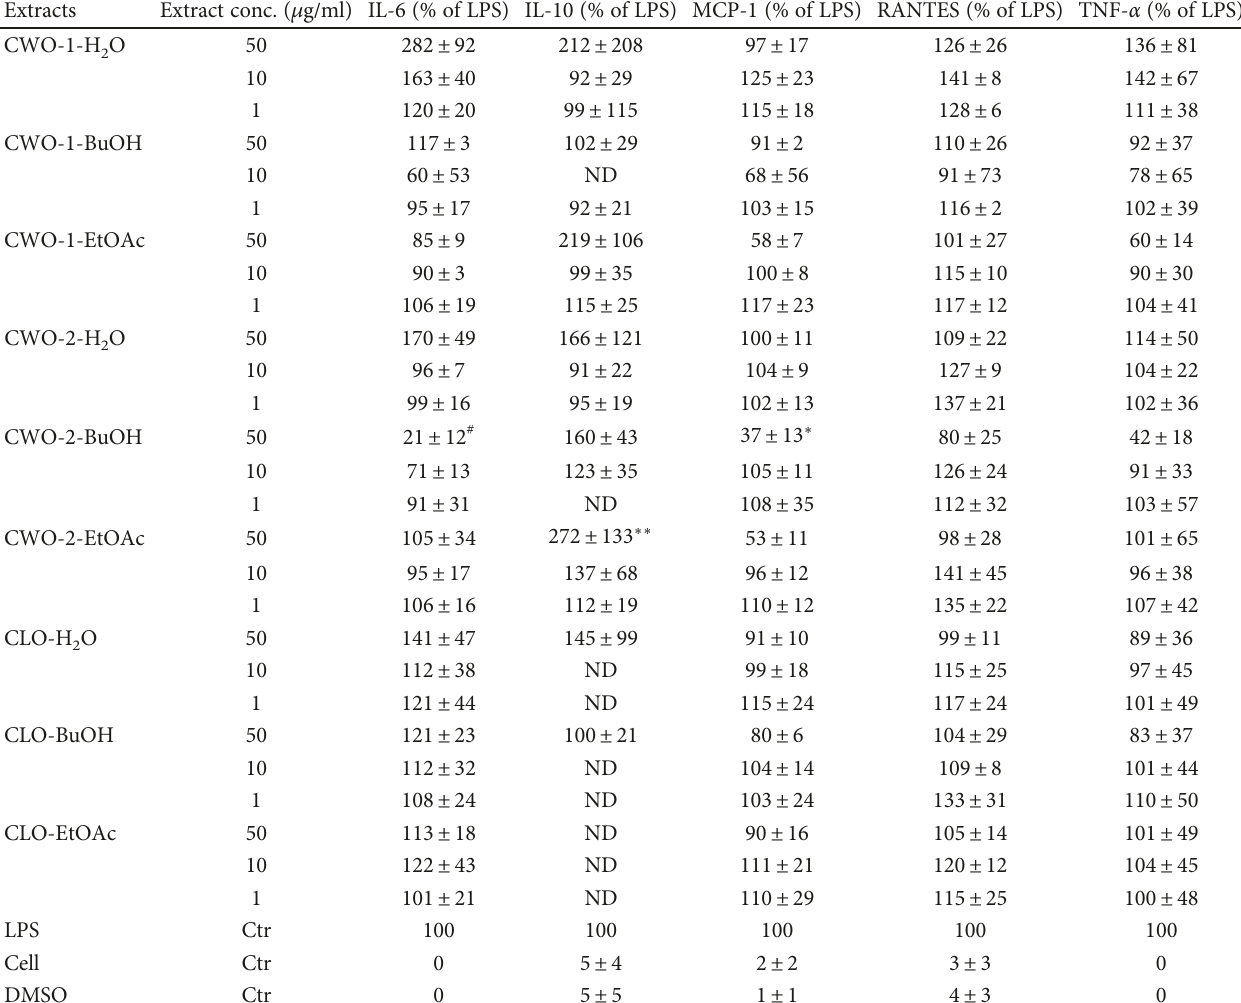
Table 1: Cytokine responses in LPS-induced THP-1 cells treated with di ff erent extracts result in relative % compared to LPS control. ∗ p < 0 05 compared to LPS control, ∗∗ p = 0 054 compared to LPS control and p = 0 077 compared to CLO-EtOAc 50 μ g/ml, and interleukin-6; IL-10: interleukin-10; RANTES: regulated on activation, normal T cell expressed, and secreted; LPS: lipopolysaccharide; CWO: cold-pressed whale oil; CLO: cod liver oil; EtOAc: ethyl acetate; BuOH: butyl alcohol. Extracts Extract conc. ( μ g/ml) IL-6 (% of LPS) IL-10 (% of LPS) MCP-1 (% of LPS) RANTES (% of LPS) TNF- α (% of